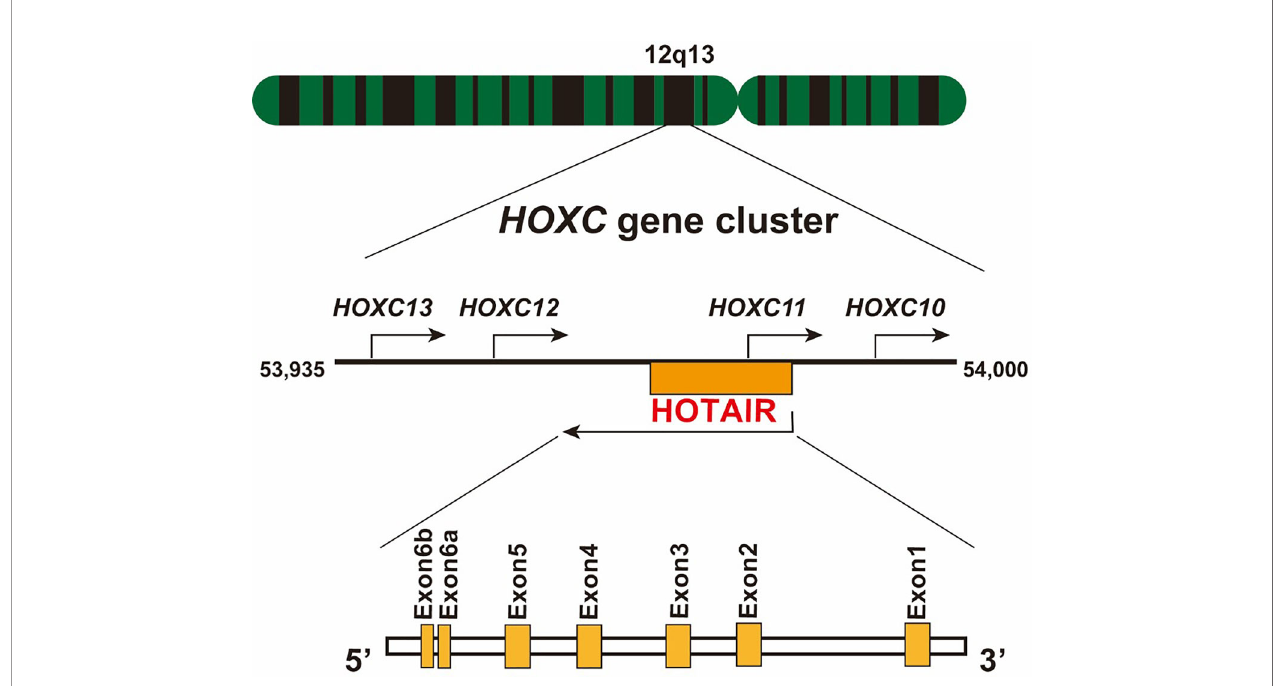
FIGURE 1 | Schematic location of lncRNA HOTAIR. The HOTAIR gene is located in the center of the HOXC gene cluster on chromosome 12, speci fi cally between HOXC11 and HOXC12 , on the antisense strand. It consists of six exons, and exon 6 contains two